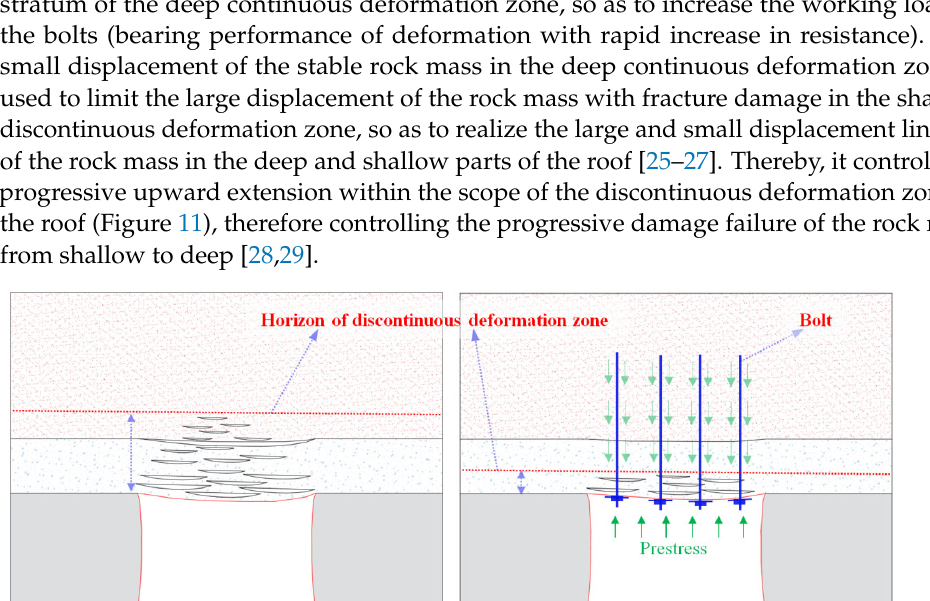
Figure 12. Cross ‐ boundary linkage control supporting scheme of the thick anchorage layer.